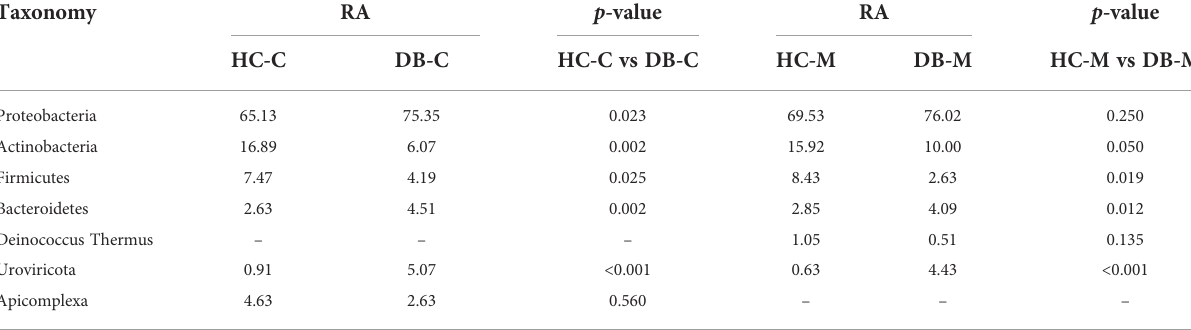
TABLE 2 Phyla in the conjunctival swab or meibum samples of controls and Demodex blepharitis